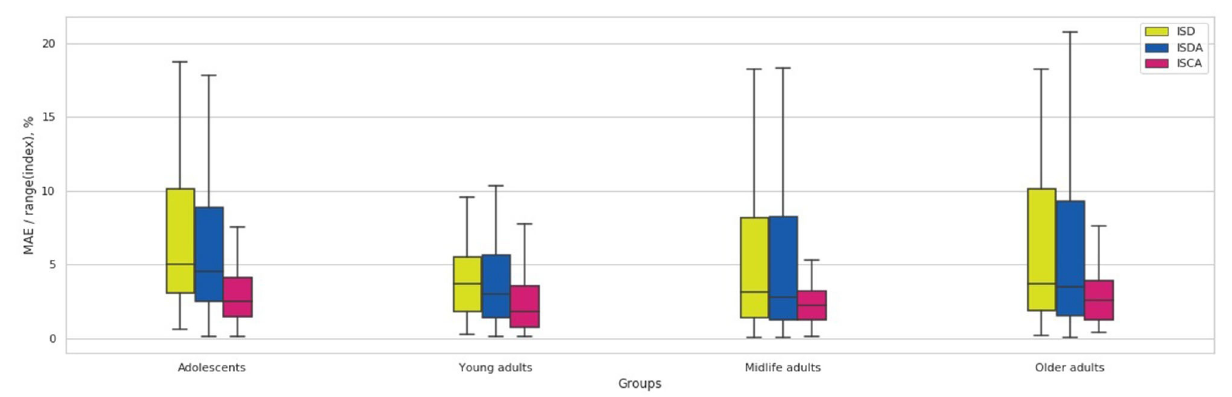
(i.e., task switching) or involves both intellectual and